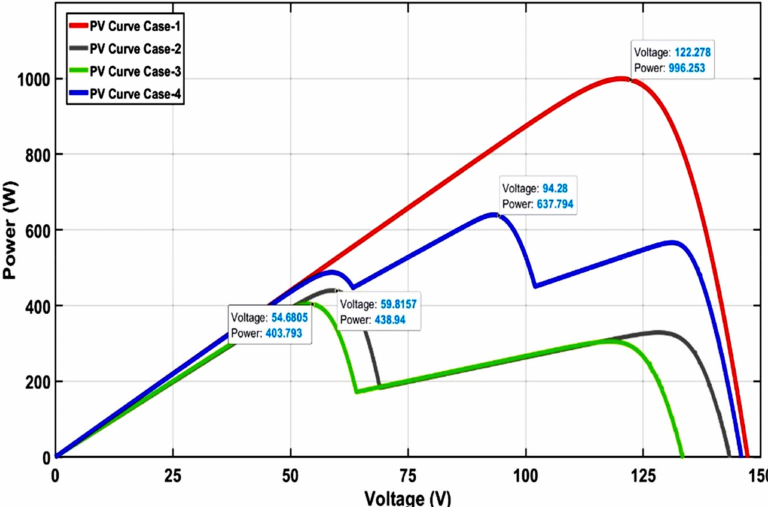
Figure 17. P-V characteristics of Array (All Cases).